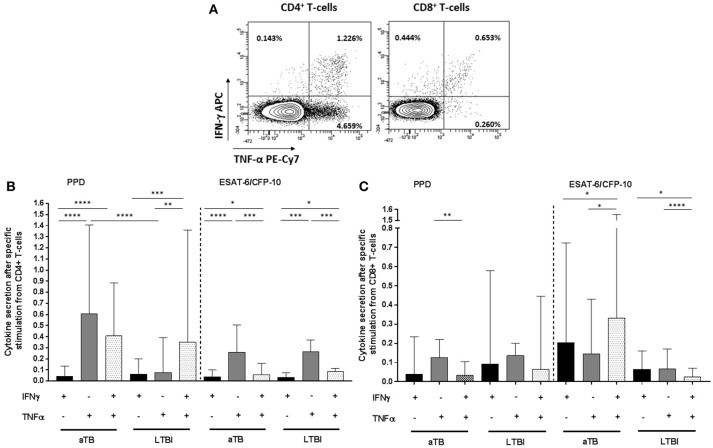
CD4+/CD8+ T-cells specific cytokine secretion phenotype regarding active TB or LTBI. (A) Dot plots from one active TB representative donor showing the expression of CD4+ and CD8+ T-cells producing IFN-γ and/or TNF-α after PPD stimulation. The frequency of the different cytokines production profile from the total CD4+ and CD8+ T-cells is indicated in each dot plot. (B) CD4+ T-cells and (C) CD8+ T-cells cytokine secretion after PPD or ESAT6/CFP10 stimulation. Black bars represent T-cells which only produce IFN-γ cytokine. Gray bars correspond to T-cells which only produce TNF-α. Dotted bars represent T-cells producing both IFN-γ and TNF-α cytokines. Bars depict medians with interquartile ranges. Differences between conditions were calculated using the two-tailed Mann-Whitney U-test. Only significant differences are represented in the graphs. *p < 0.05, **p < 0.01, ***p < 0.001, ****p < 0.0001. aTB, active TB; LTBI, latent tuberculosis infection.